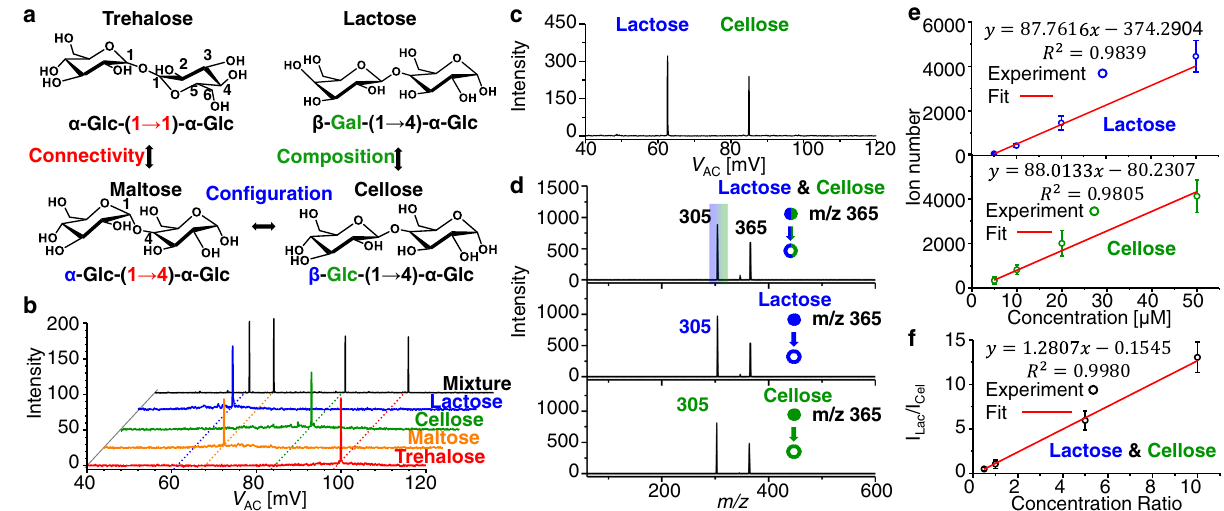
Fig.2|Structuralanalysisofglycans.a Structuresoffourisomericdisaccharides, which have isomerization of composition, connectivity, and con fi gurationin pairs. b Ion cloud pro fi ling spectra of the four disaccharides: trehalose (red), maltose (orange),cellose(green),lactose(blue),andthemixtureofthesefour(black). c Ion cloud pro fi ling spectrum of lactose and cellose mixture. d Tandem MS spectra of lactose and cellose mixture (top), pure lactose (middle), and pure trehalose (bot- tom). Lactose (blue) and cellose (green) have identical mass to charge ratio, m/z